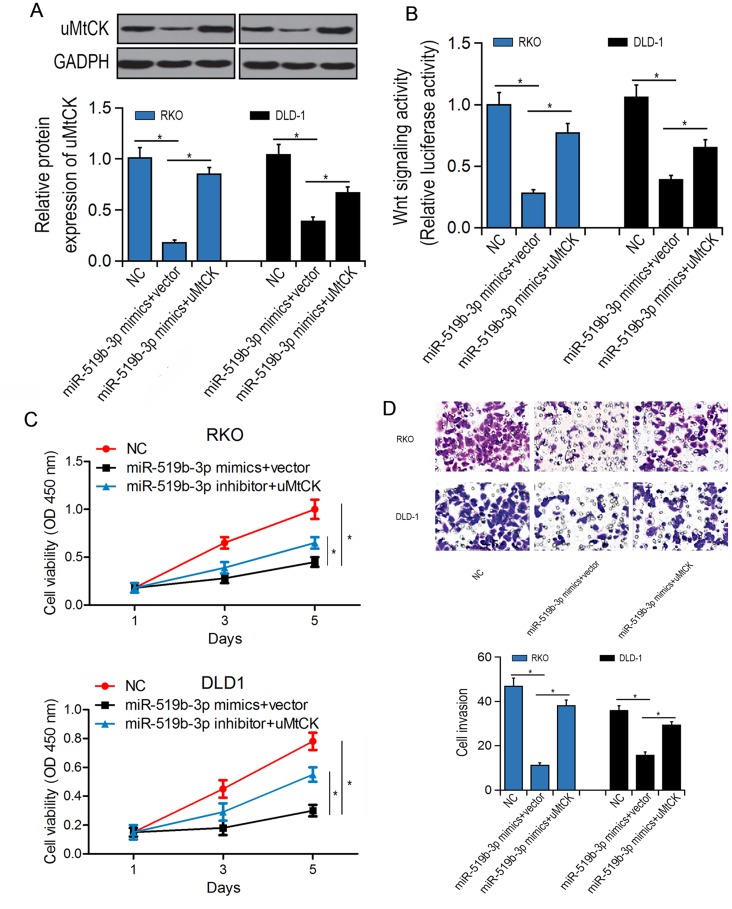
Restoration of uMtCK expression abolishes the antineoplastic activity of miR-519b-3p. DLD-1 and RKO cells were transfected with miR-519b-3p mimics and pcDNA3.1/uMtCK expression vector and cultured for 48 h. (A) Protein expression of uMtCK was detected by Western blot. (B) Wnt signaling was examined by TOPFlash reporter assay. (C) Cell proliferation was detected by CCK-8 assay. (D) DLD-1 and RKO cell invasions were assessed by Transwell invasion assay. *p < 0.05.